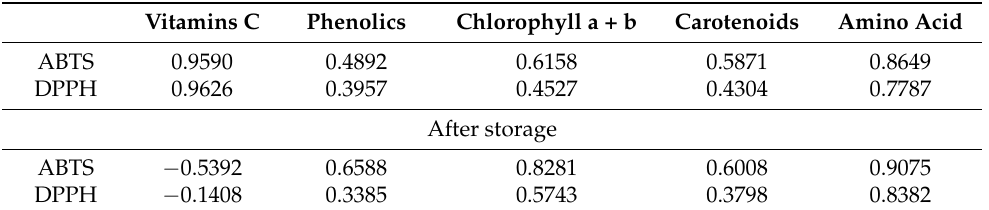
Table 4. Correlation of antioxidant activity and bioactive compound content in fresh and stored cab-